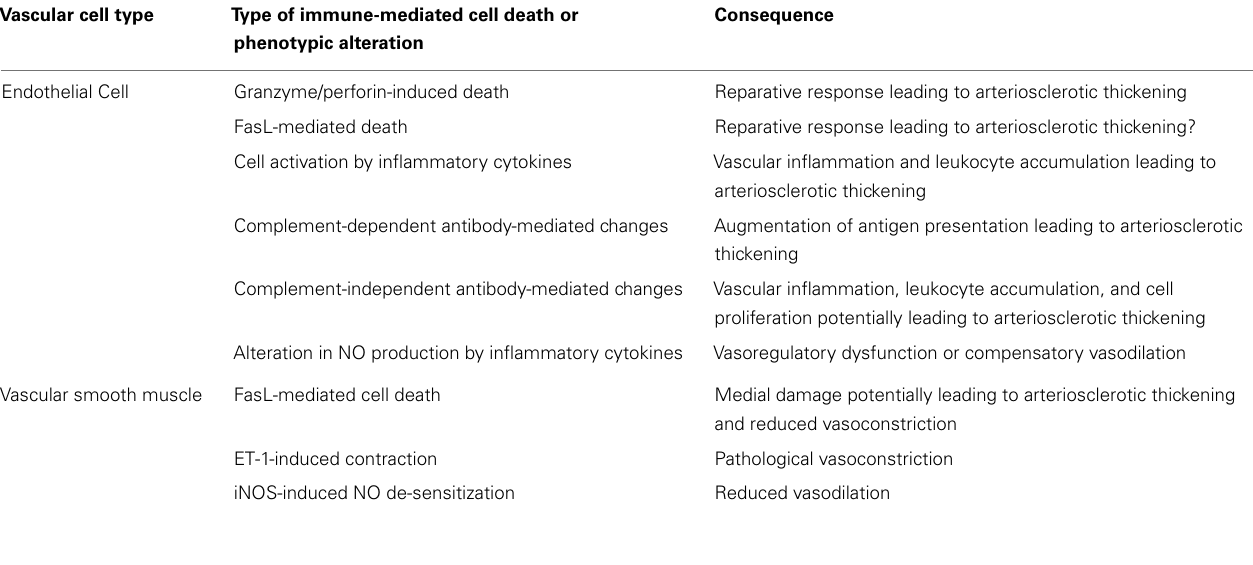
Table 1 | Immunological effects on vascular cells and their consequences to arterial structure and function inTA . Vascular cell